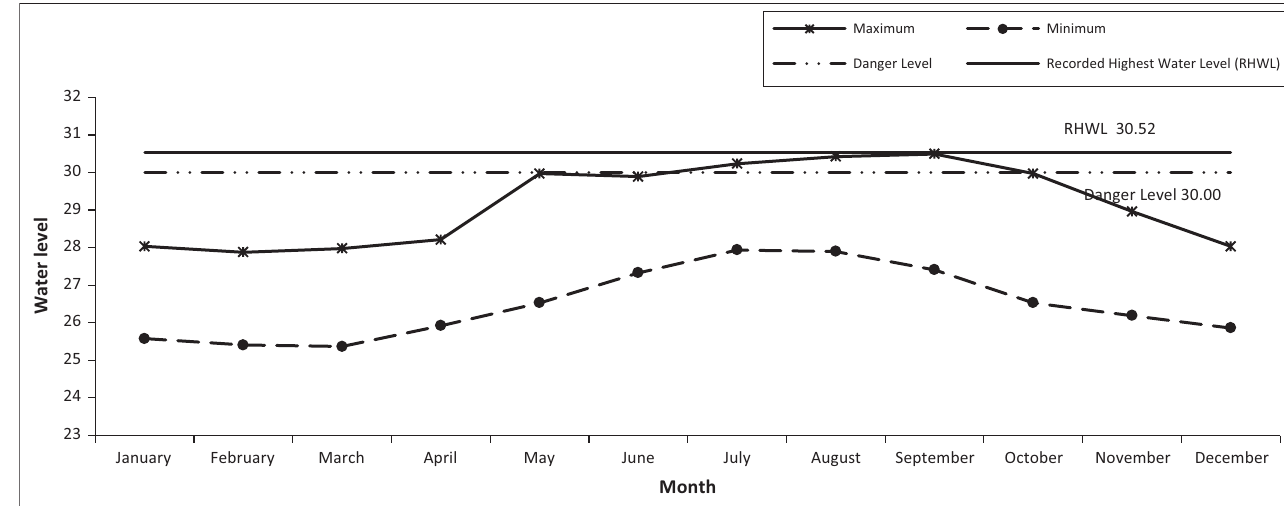
FIGURE 9: Monthly recorded maximum and minimum water level at Kaunia station from 1985 to 2006.